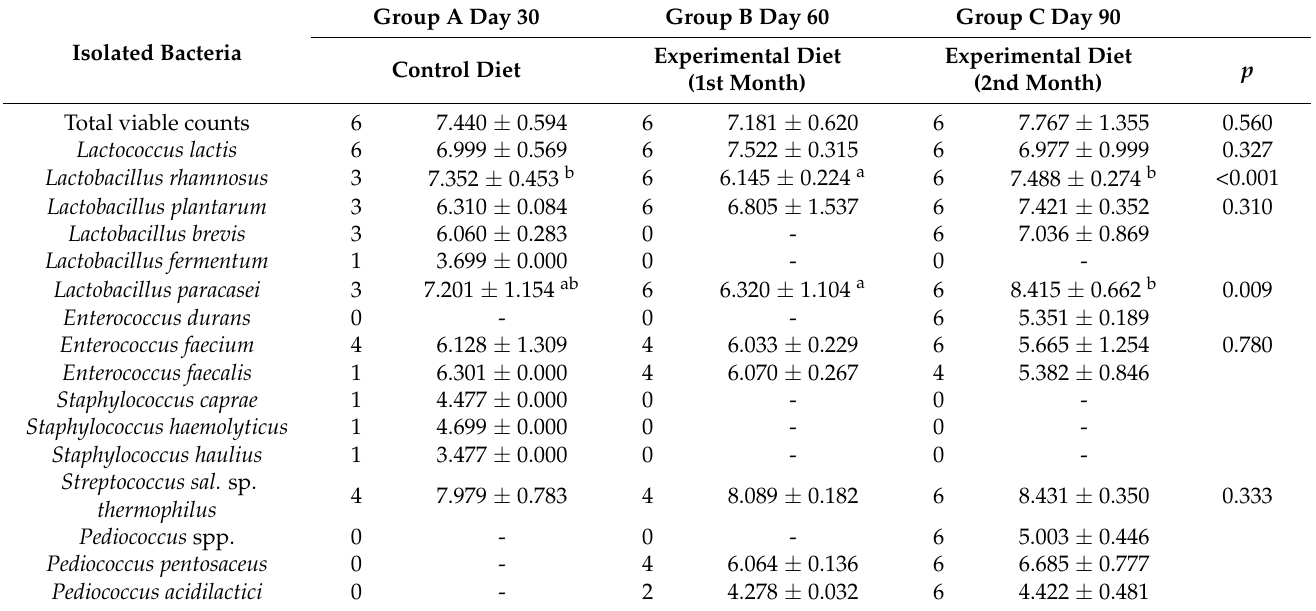
Table 2. Distribution of the identified microbial species (log cfu/mL) showing the number of Kefalograviera cheese samples in which each microbial species was identified (6 in total for each group) and the mean counts ( ± standard